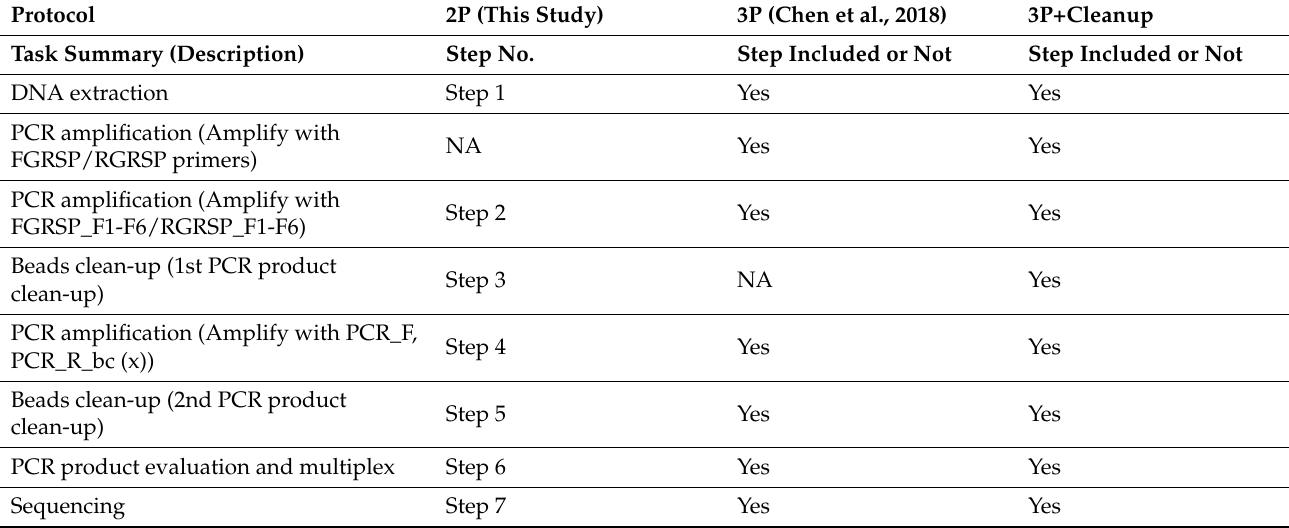
Table 1. Cross comparison of the steps applied for two-step PCR (2P), three-step PCR (3P), and three-step PCR with bead clean-up (3P+cleanup) protocols. Forward Gene Region-Specific Primer (FGRSP, e.g., ITS1F, 341F, and 515F) and Reverse Gene Region-Specific Primer (RGRSP, e.g., ITS2, ITS4, and 806R) can be replaced by forward and reverse primers of interest, respectively. x = barcode ID. Each of the 2P steps (Step 1–7) were described in detail in Figure 2.